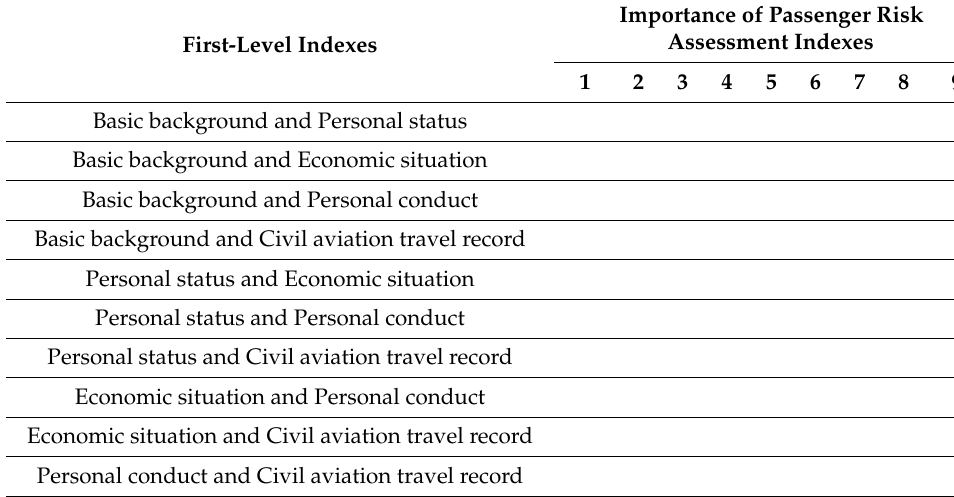
Table A1. First-level indexes.